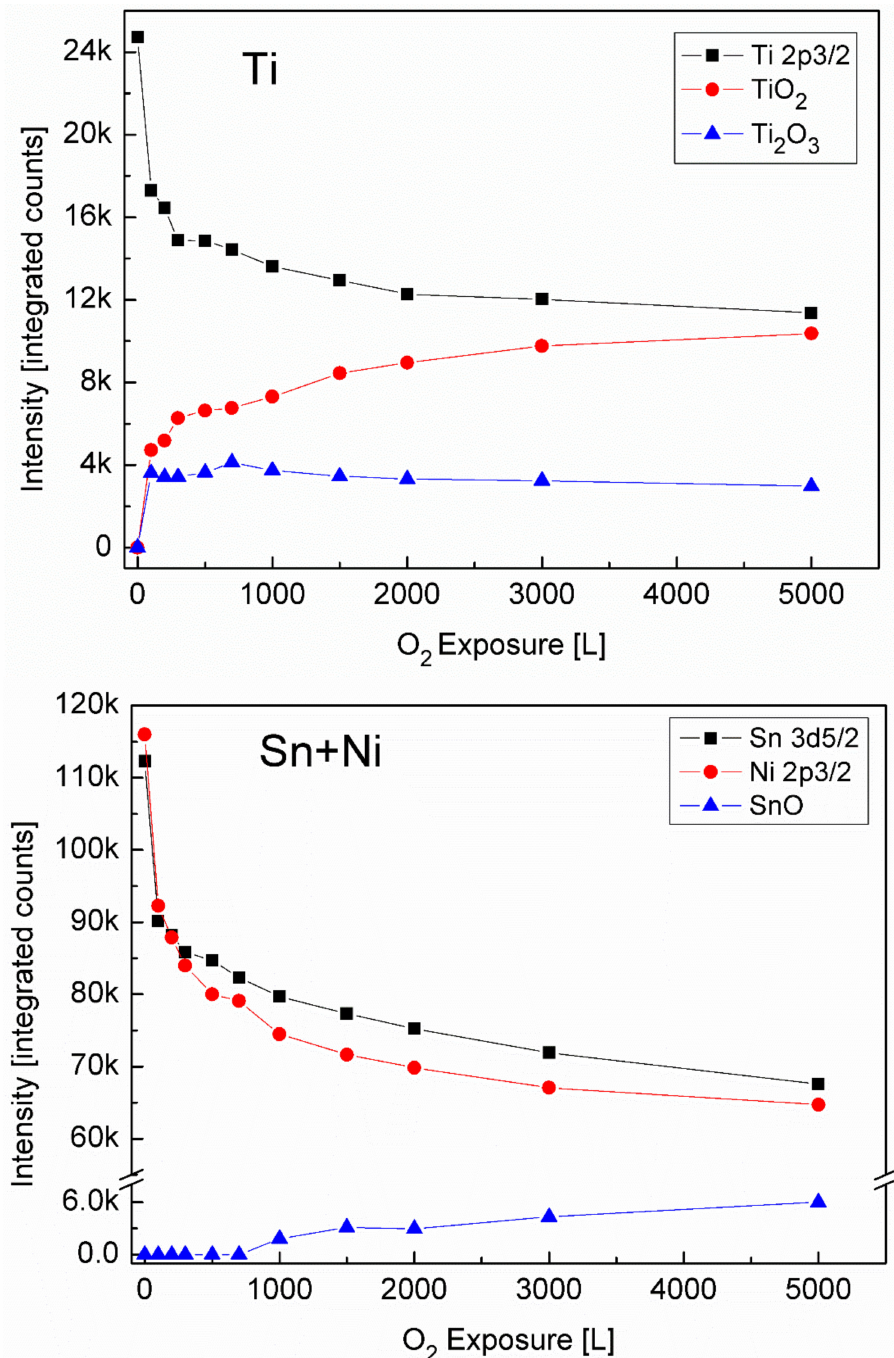
Figure 5. The metallic and oxides intensity of Ti, Ni and Sn vs. oxygen exposure at Room Temperature